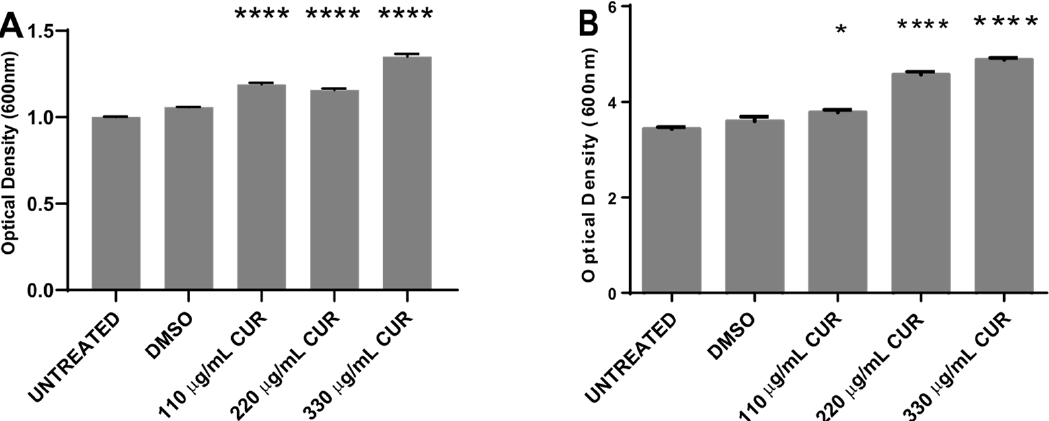
Figure 2. Dose–time response curves comparing curcumin (CUR) treatment in S . enterica ser. Typhimurium growth (OD600), and for cells incubated in the presence of dimethyl sulfoxide (DMSO). Curves are representative of at least 3 different assays. ( A ) After 4 hours of incubation. ( B ) After 12 hours of incubation. (* p < 0.05, **** p < 0.0001). Table 1. Number of colonies on agar plates.